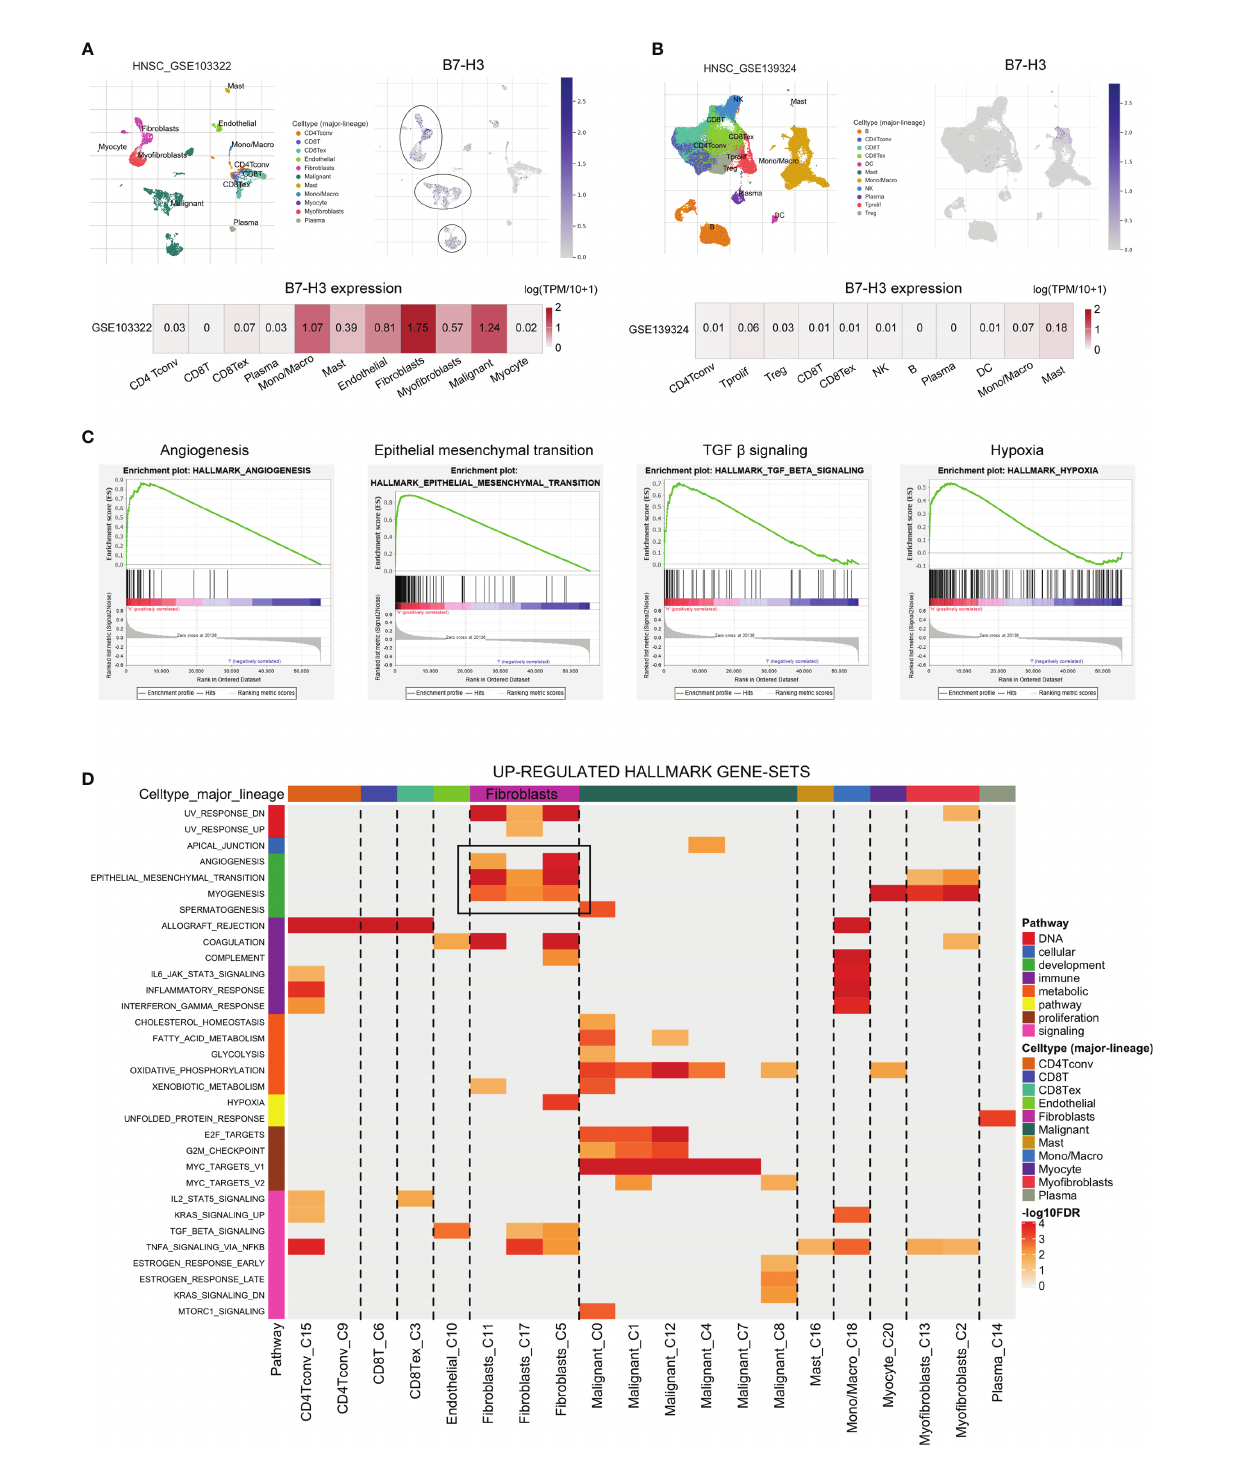
FIGURE 3 | The single-cell RNA sequencing analysis exhibits the expression pattern as well as the signal pathway of B7-H3. (A, B) The t-SNE projection of all cells and B7-H3 expression from GSE103322 and GSE139324; (C, D) GSEA derived from bulk RNA-seq (C) and scRNA-seq (D) data presents the underlying pathway associated with